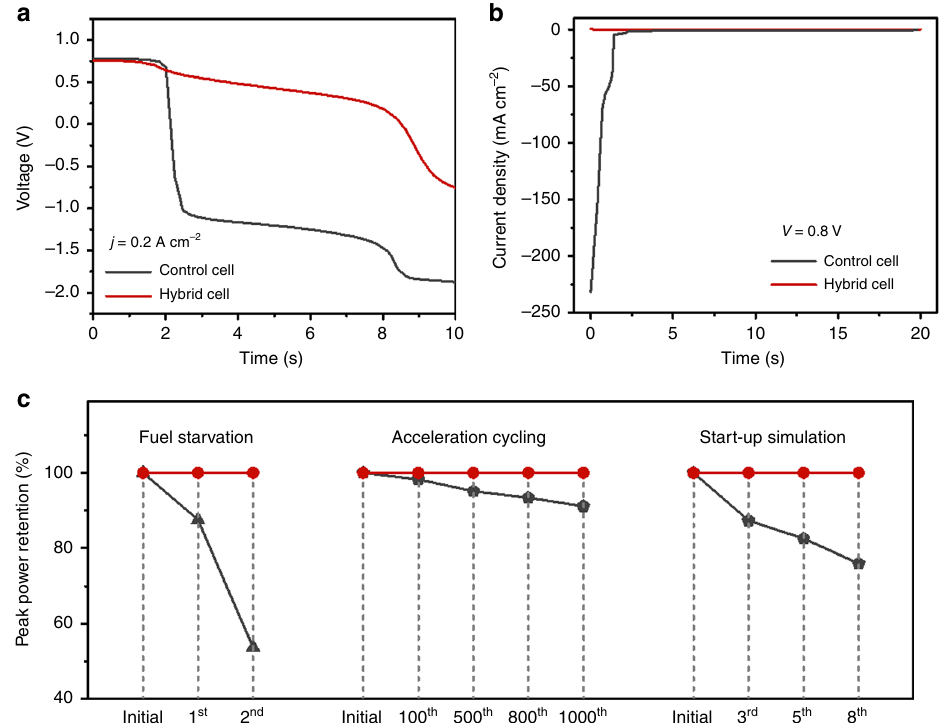
Fig. 5 Hybrid fuel cells with improved durability against different operating conditions. a Voltage pro fi les of a control cell and a hybrid cell operated under a constant current density of 0.2 A cm − 2 in response to switching the H 2 fl ow to N 2 fl ow. b Current pro fi les of a control cell and a hybrid cell operated under a constant voltage of 0.8 V in response to air intrusion to the anodes. c Retention of the peak-power density of three control cells and a hybrid cell after three accelerated stress tests (see the polarization curves in Supplementary Fig. 12). The hybrid cell was used throughout all three tests (red line). For the control cell testing (black line), one cell was used for each test. All of the tests were conducted at 50 °C, and detailed testing conditions are provided in the